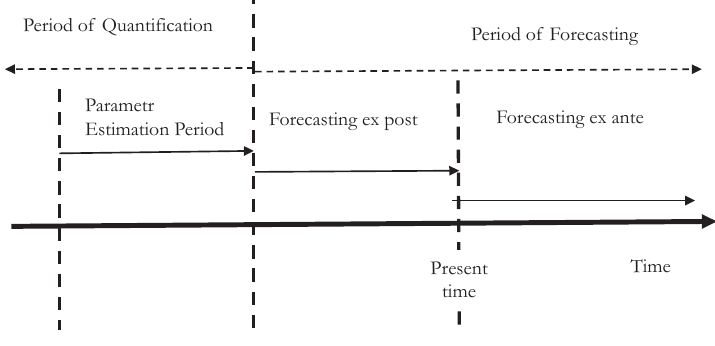
Fig. 2 – Time in Forecasting. Source: own according to Marček (2013), Vincúr (2007) Data for the main raw materials of the food industry, namely wheat food, wheat forage, malting barley, milk, apples and potatoes, has been analyzed. The data was obtained from the Czech Statistical Office from the monthly data collections from January 2009 to February 2018 in the Czech Republic. The data file has been analyzed and modified. Missing values were found re- garding milk and potatoes and replaced by linear interpolation. Descriptive statistics of the data are defined in Table